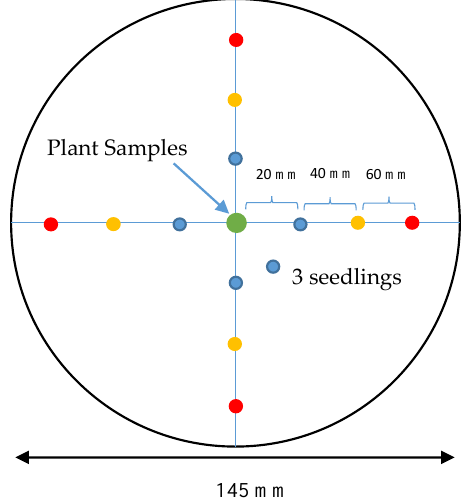
Figure 3. The layout of the single petri dish (SPD) method: the control level of growth of the L. sativa seedling by volatile allelochemicals in the glass petri dish desk. Different coloured dots represent the various distances (20 mm, 40 mm, and 60 mm) and directions of the tested L. sativa seeds.